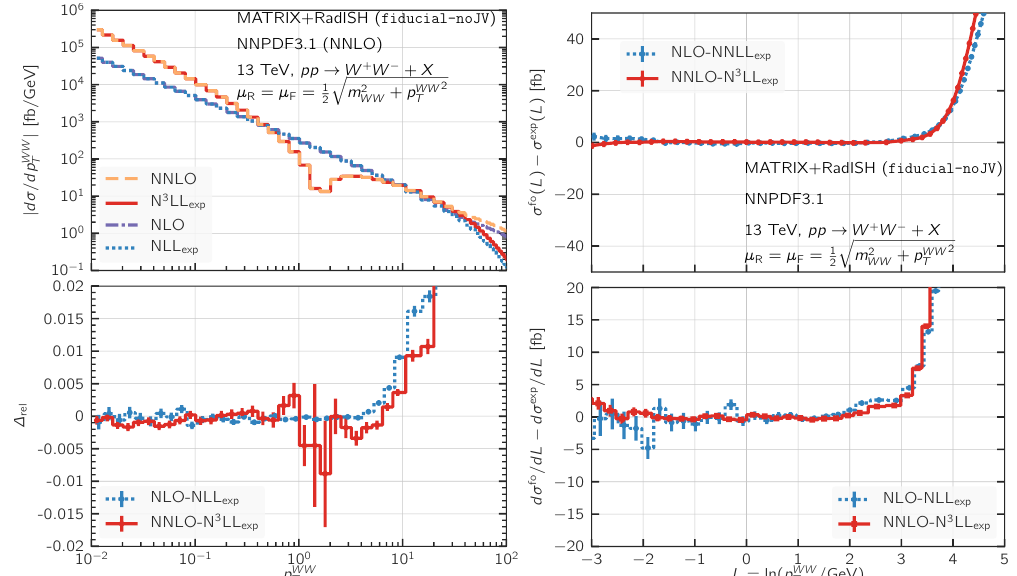
Figure 1 . Left plot: transverse-momentum spectrum of the W + W − pair at NLO (purple, dot- dashed) and NNLO (orange, dashed), and the expansion of the NLL (blue, dotted) and N 3 LL (red, solid) cross section. The lower panel shows the relative difference eq. (2.22) between the fixed-order cross section and the expansion. Right plot: the upper panel shows the difference at the cumulative level between NLO and NLL expansion (blue, dotted), and between NNLO and N 3 LL expansion (red, solid). The lower panel shows the same results for the derivative of the cumulative cross section with respect to ln( p WW / GeV) T